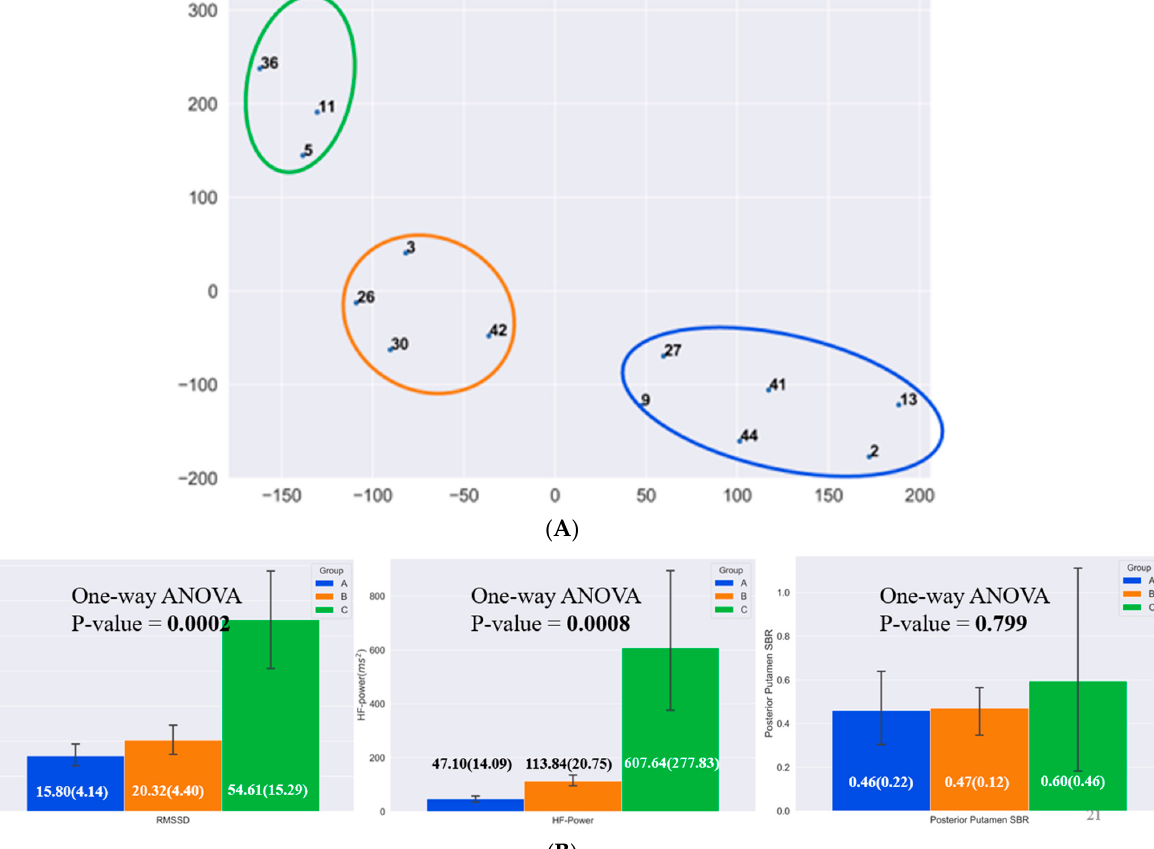
Figure 6. ( A ) T-SNE clustering of patients by posterior putamen SBR (PP), HF-power, and RMSSD. Blue oval: Group A; Orange oval: Group B; Green oval: Group C. ( B ) One-way ANOVA results of PP, HF-power, RMSSD show significant difference between the groups for HRV parameters only and not with PP.